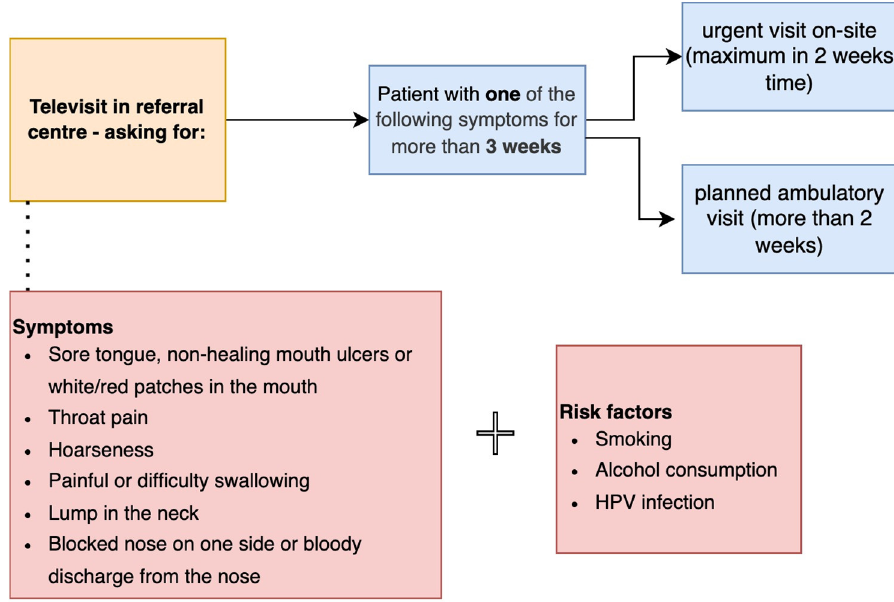
Figure 1. Proposed referral algorithm for patients with suspicious head and neck